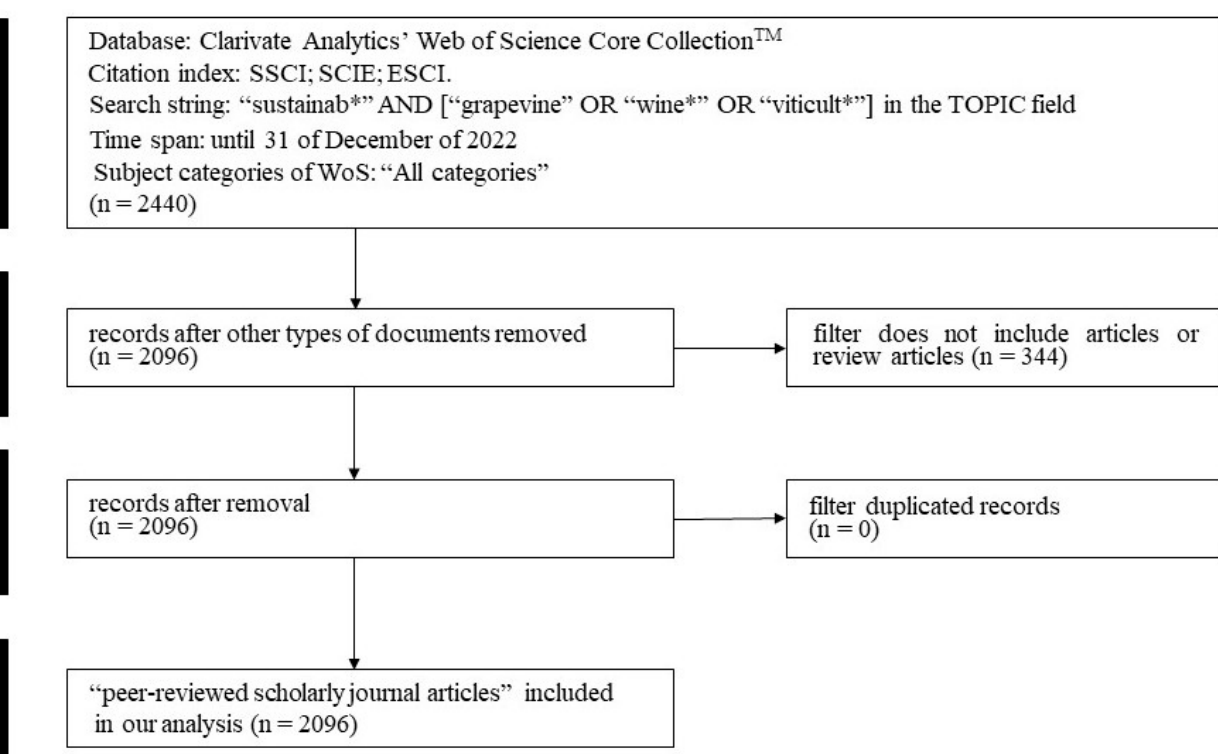
Figure 1. Screening by using PRISMA methodology .